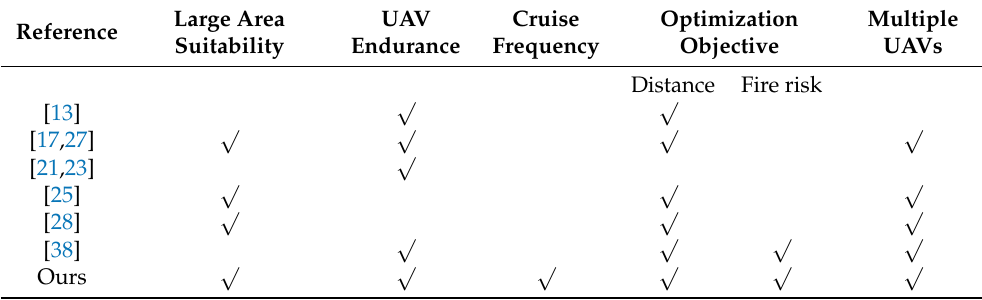
Table 1. Factors considered in path planning methods in the